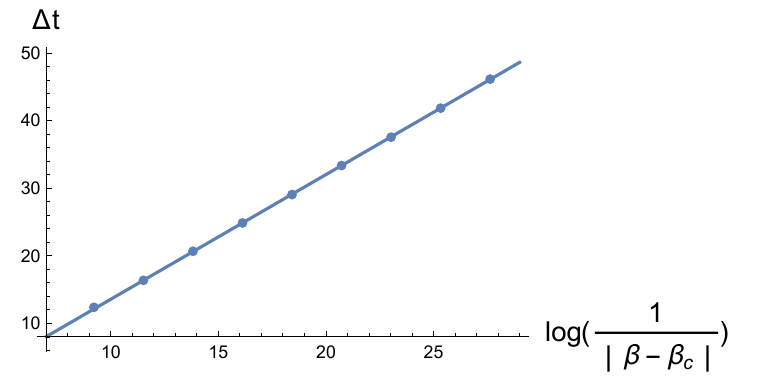
Figure 18 . Scaling of the permanence time (cid:1) t along the unstable SPS with ! b =